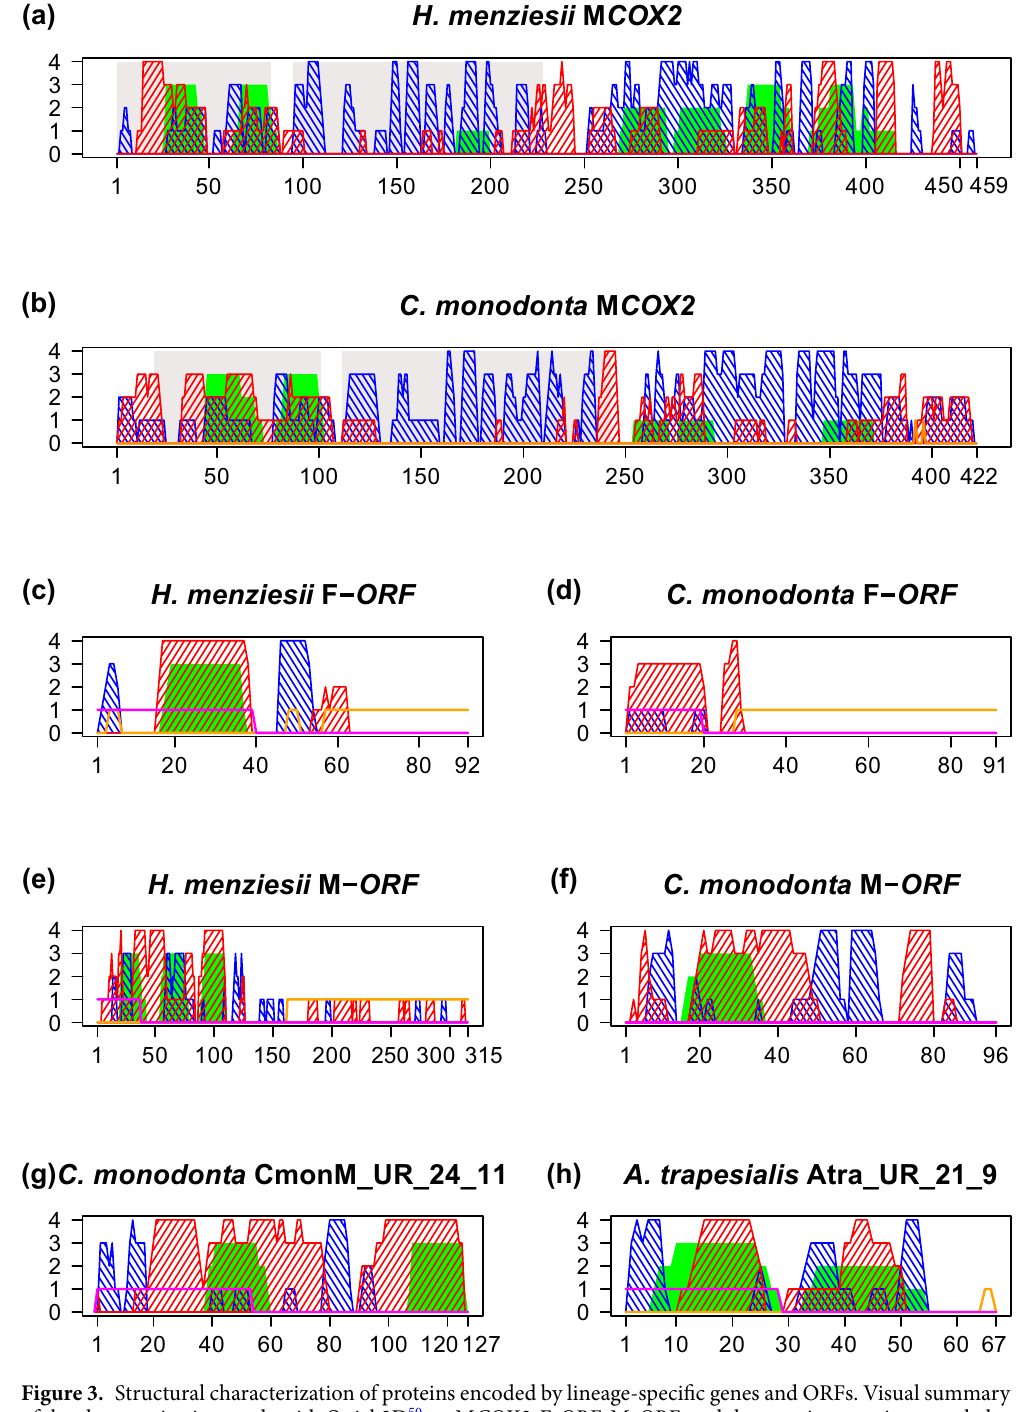
Figure 3. Structural characterization of proteins encoded by lineage-specific genes and ORFs. Visual summary of the characterization made with Quick2D 50 on M COX2 , F- ORF , M- ORF , and the putative proteins encoded by the ORFs CmonM_UR_24_11 and Atra_UR_21_9 from Hyridella menziesii , Cumberlandia monodonta , and Anodontites trapesialis mtDNAs. Complete Quick2D outputs are displayed in Supplementary Information 5. In each panel, on the X axis are the amino acid positions of the protein, while on the Y is the support for each feature (described below) shown in terms of how many methods indicated a certain characteristic at a given position. Colour code of features: full green areas, transmembrane regions; striped red areas, regions forming helices; striped blue areas, regions forming beta-sheets; purple lines, signal peptide signature; orange lines, disordered regions. The two grey squares on the background of panels ( a ) and ( b ) represent, from left to right, the boundaries of the conserved transmembrane and periplasmic domains of COX2